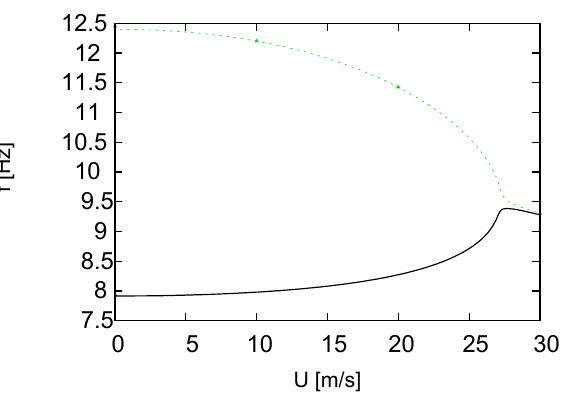
Fig. 7. The frequency of vibrating airfoil in dependence on the far field velocity U ∞ for the second considered aeroelastic prob- lem. The results obtained by the linearized aerodynamical the- ory (solid line) and by the finite element method (symbols) are shown.